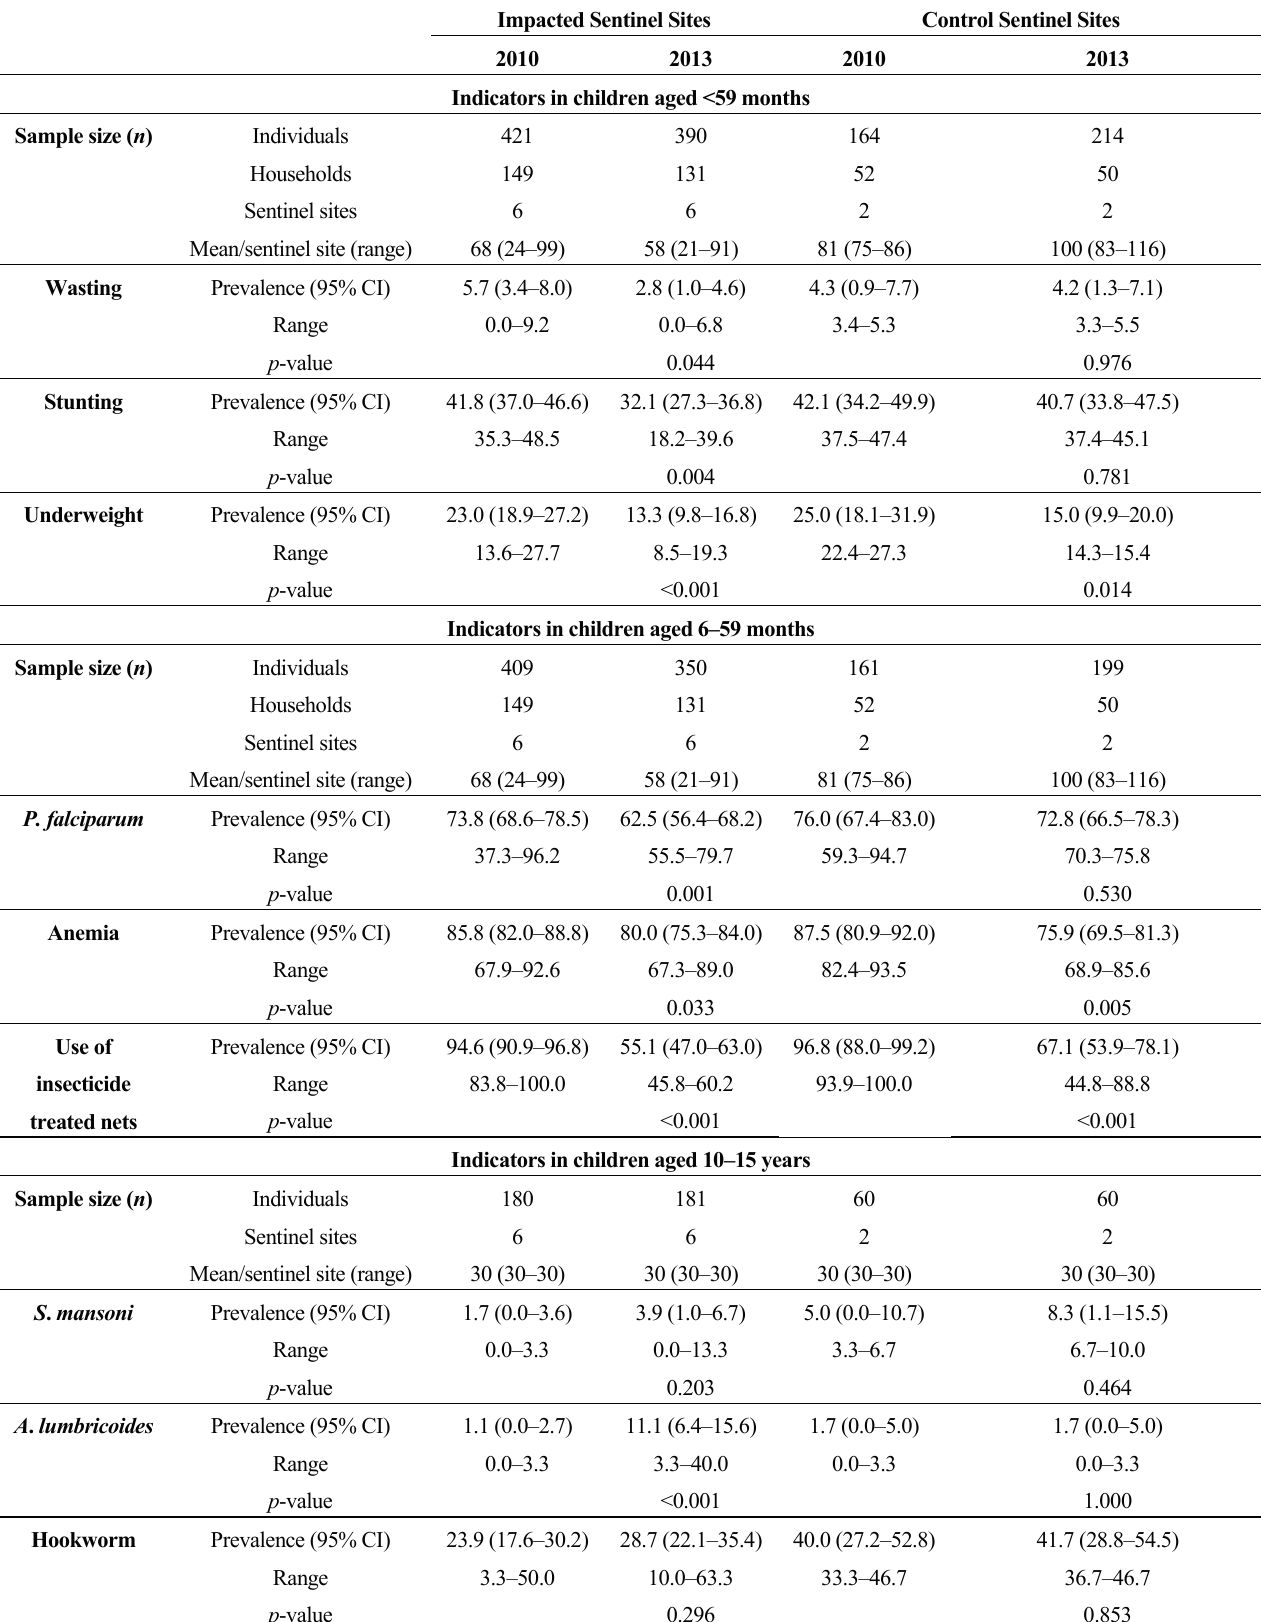
Table 2. Key health indicators at the impacted and the control sentinel sites, in the ABSL project study area, 2010 and